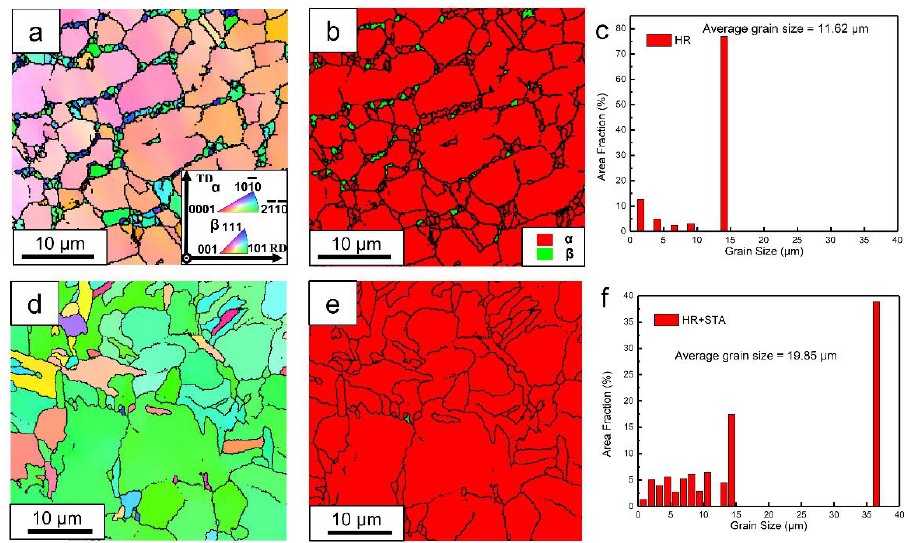
Figure 3. IPF images, phase maps, and column distribution of grain size maps of LD-Ti423 alloys. ( a – c ) hot-rolled condition; ( d – f ) STA